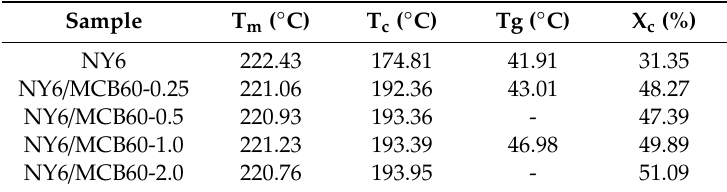
Table 6. Di ff erential scanning calorimetry (DSC) data for the Nylon 6 and NY6 / MCB60 nanocomposites.